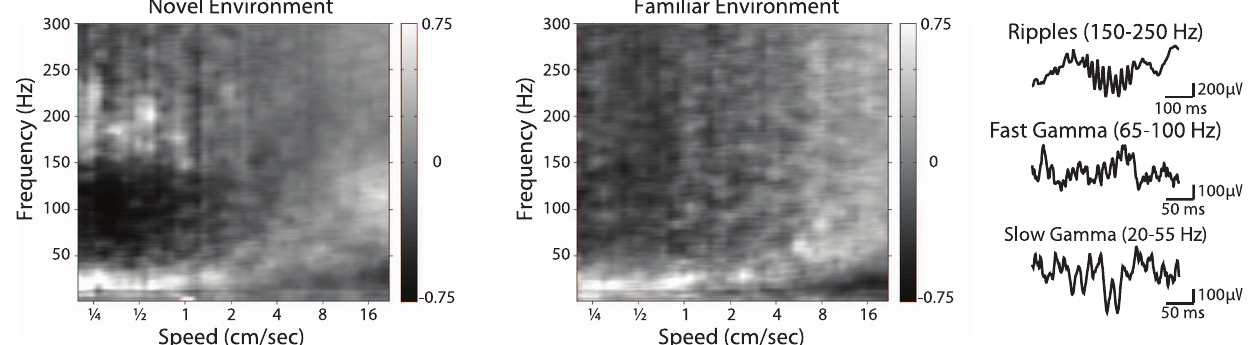
Figure 2. The spectrum of rhythmic local field potential activity in area CA1 is smoothly modulated by behavior. Example spectrograms across speeds. Power in each frequency is shown as a z-score relative to the mean power across speeds. (left) Spectrogram calculated in the first exposure to a novel environment. (middle) Spectrogram calculated after the environment has become familiar (epoch 12). (right) Three known and physiologically relevant rhythms, the ripple oscillation (150–250 Hz), fast gamma (65–100 Hz), and slow gamma (25–55